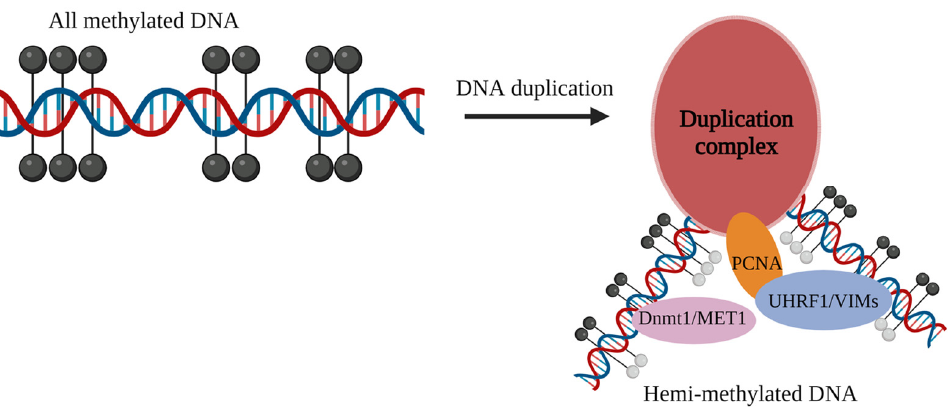
Figure 6. Cytosine DNA